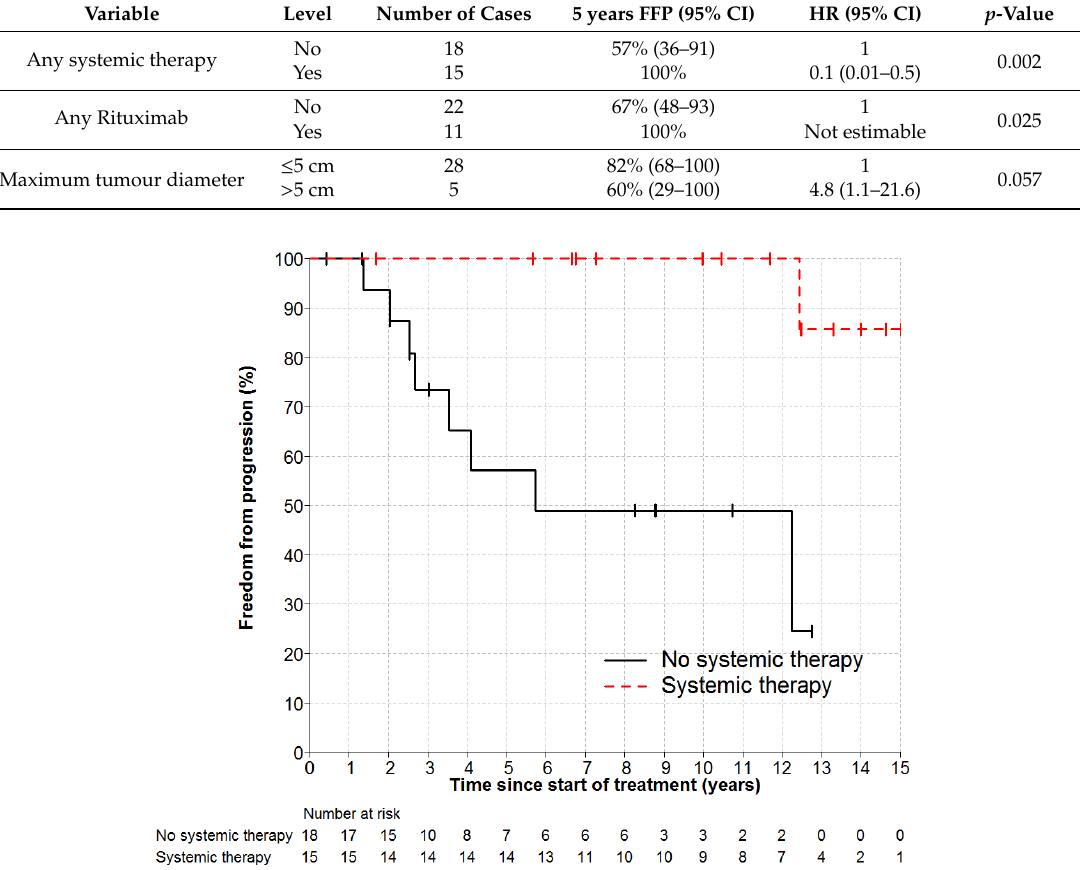
Figure 4. Freedom from Progression by any Systemic Therapy HR 0.1, p = 0.002. Cancers 2020 , 12 , x doi: